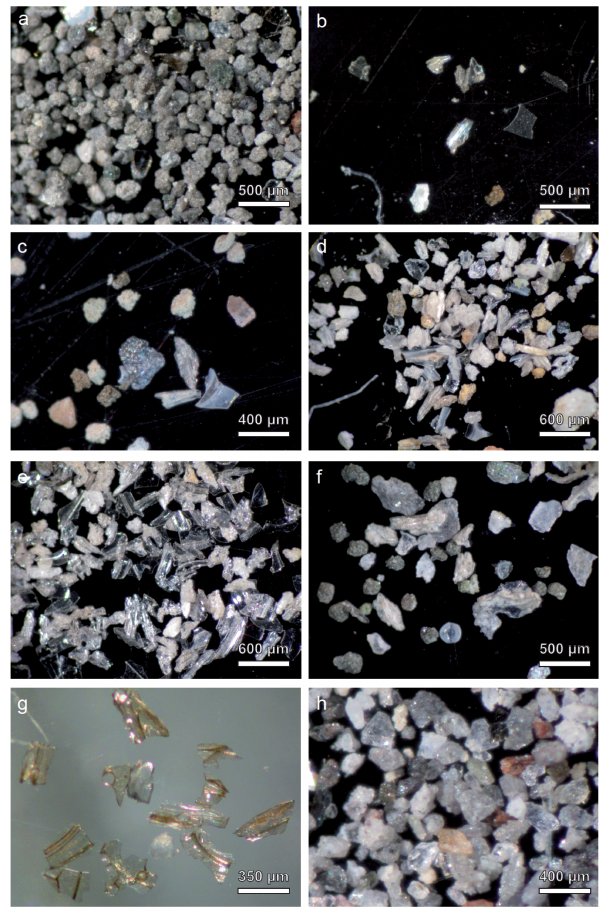
Fig. 3. Selected microphotograph of the investigated tephras and cryptotephras: (a) greenish to light brownish micro-pumice frag- ments of PT0915-1, (b) thin and transparent glass shards of PT0915-2, (c) white vesicular glass shard with sick septa of PT0915-3, (d) highly vesicular, white micro-pumice and white to brown glass shards of PT0915-5, (e) 100% transparent glass shards and highly vesicular micro-pumice of PT0915-7, (f) highly vesic- ular glass shards of PT0915-8, (g) transparent to light brown thick bubble-walled (partly Y-shaped) glass shards of PT0915-9, (h) sco- ria fragments with black phenocrysts of